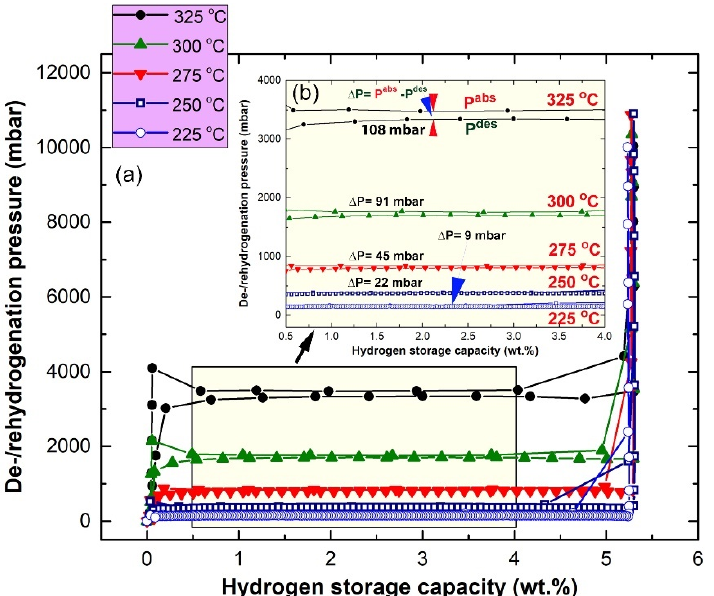
Figure 10. Pressure-composition-temperature (PCT) curves conducted at 225, 250, 275, 300 and 325 °C for nanocomposite MgH 2 /5 wt.% ZrC obtained 25 h of HEBM. ( a ) Sievert’s approach at different temperatures ( b ) wide pressure gaps ( Δ P) between the hydrogenation (P abs ) and dehydrogenation (P des ) plateaus .